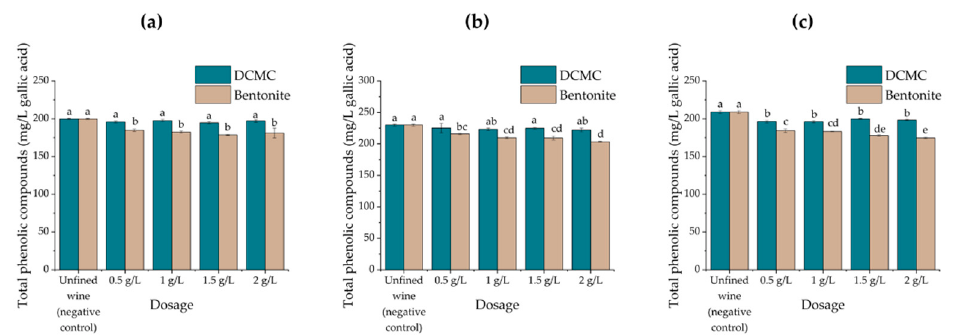
Figure 4. Changes in the amount of total wine phenolics detected by the absorbance at 280 nm for increasing amounts of bentonite or DCMC applied to samples of the wines under study. Different letters represent statistically significant differences among different homogeneous subsets for p = 0.05. ( a ) Encruzado, ( b ) Viosinho, and ( c ) Moscatel de Setúbal monovarietal wines.